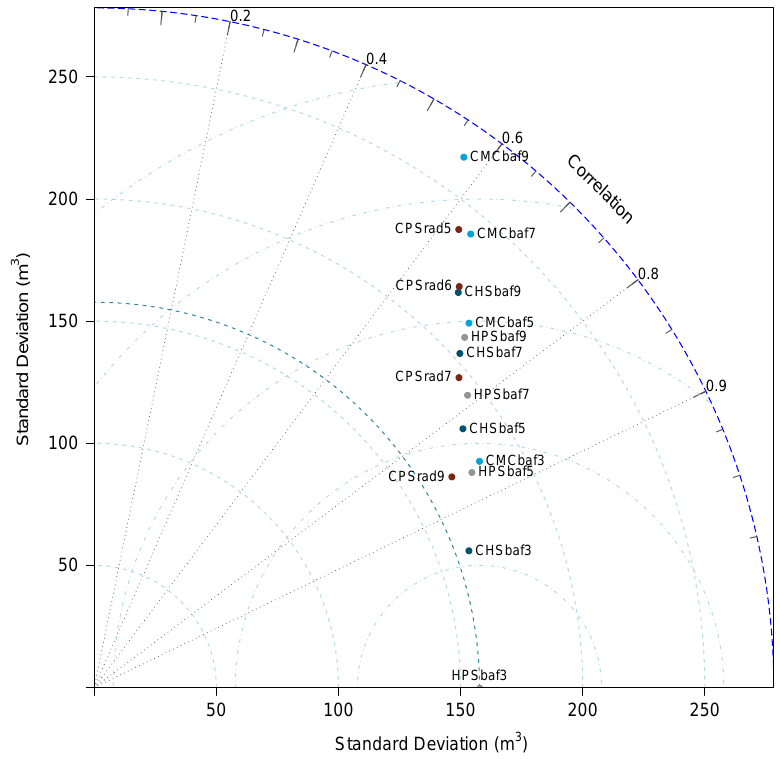
Figure 3. Taylor diagram of the simulations in Table 1, where the labels follow the convention of the standard method ‘HPSbaf3,’ which corresponds to horizontal point sampling with BAF F = 3 m 2 ha − 1